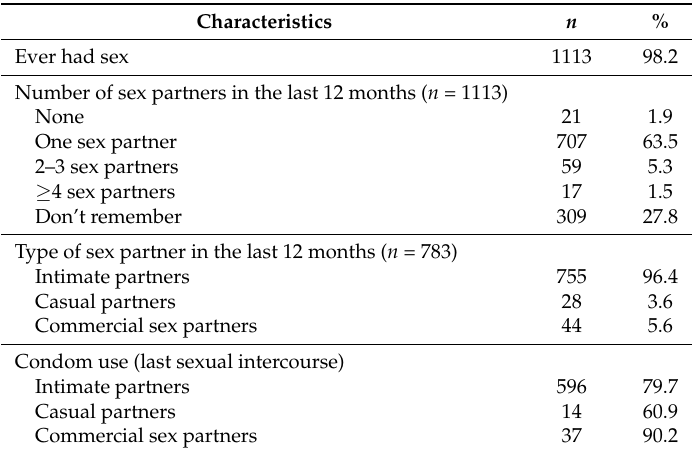
Table 3. Sexual behaviors among participants ( n = 1133).